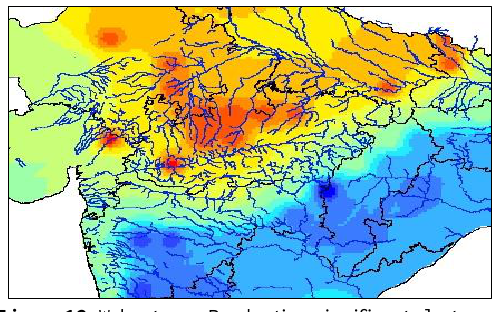
Figure 12 . Wheat crop Production significant clusters of new and consecutive cold spot coincide with the river basins of Shipra, Kali Singh, Parba and